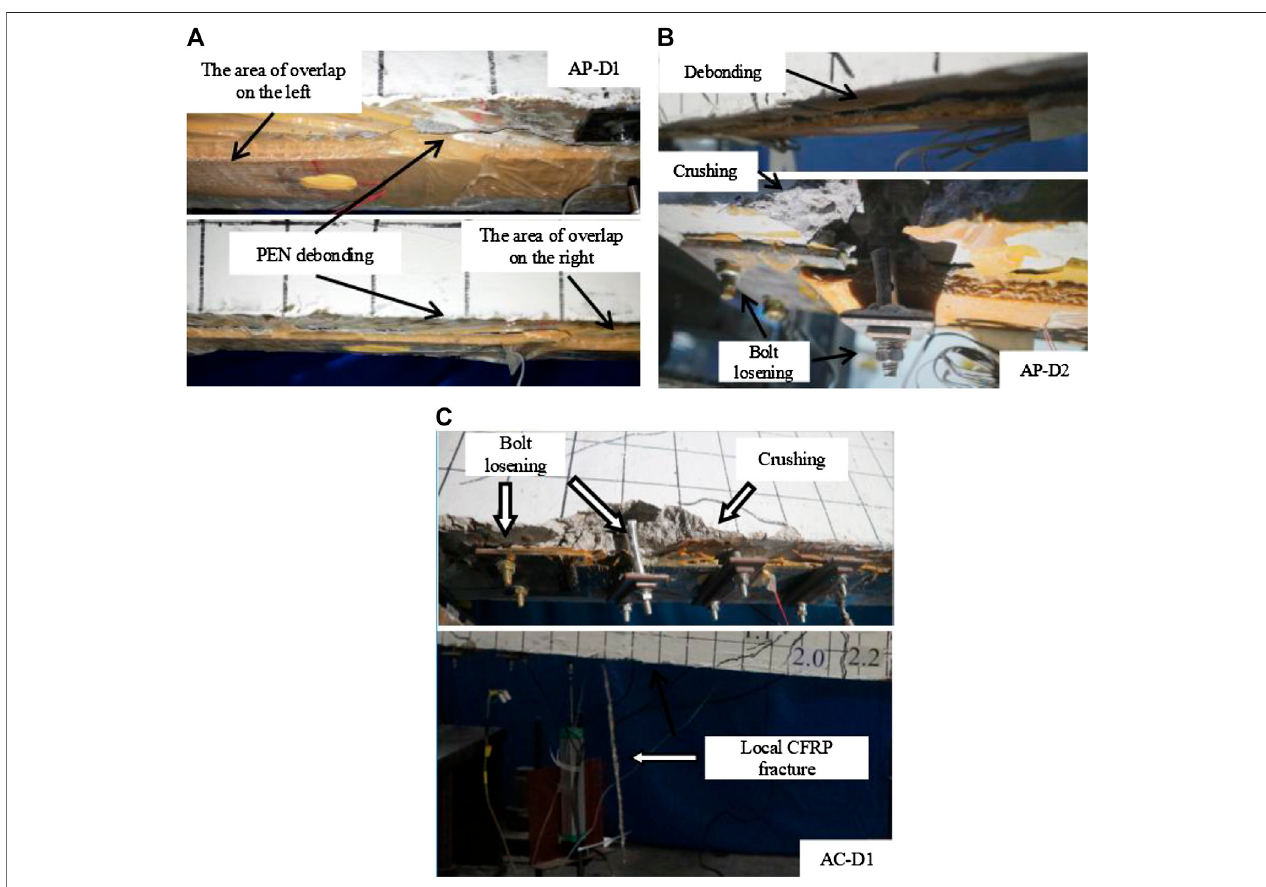
FIGURE 7 | FPR debonding failure patterns in drop-weight tests. (A) AP-D1, (B) AP-D2, (C) AC-D1.